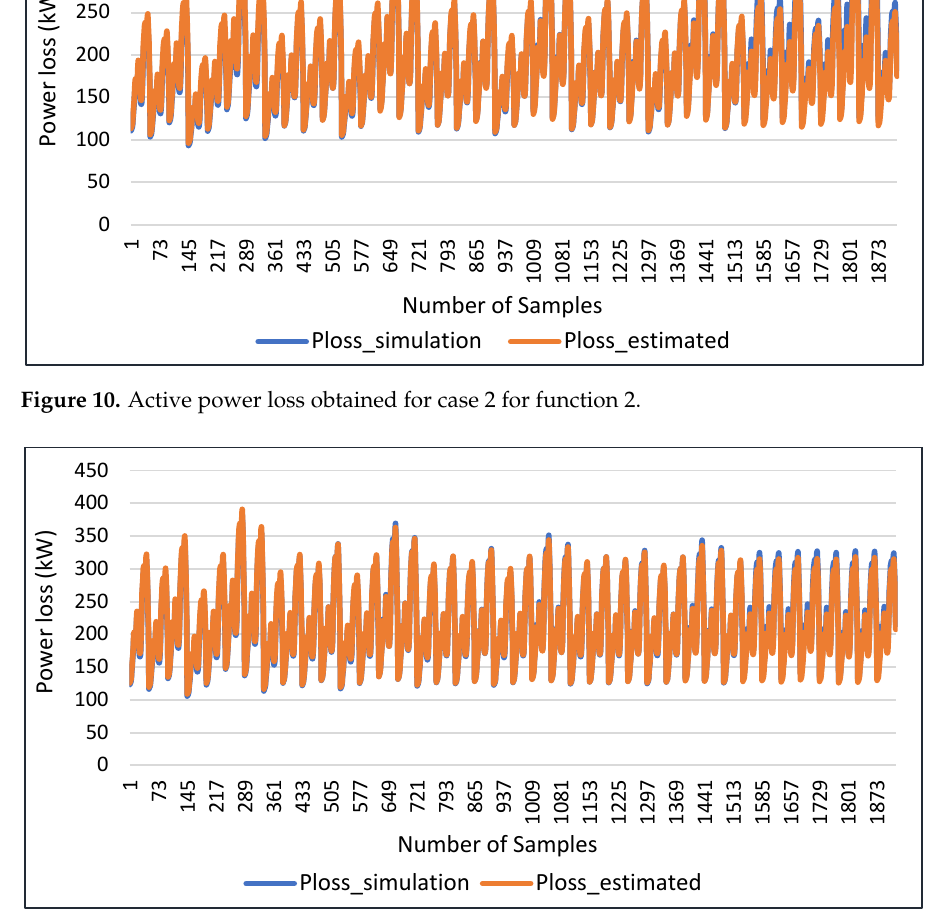
Figure 11. Active power loss obtained for case 3 for function 2. Table 11 presents the RMS error for active power loss estimation for function 2 for each ZIP case. Table 10 presents the RMS error for active power loss estimation for function 1 for each ZIP Table 11. RMS error for active power loss estimation for function 2 for IEEE-34 bus system.